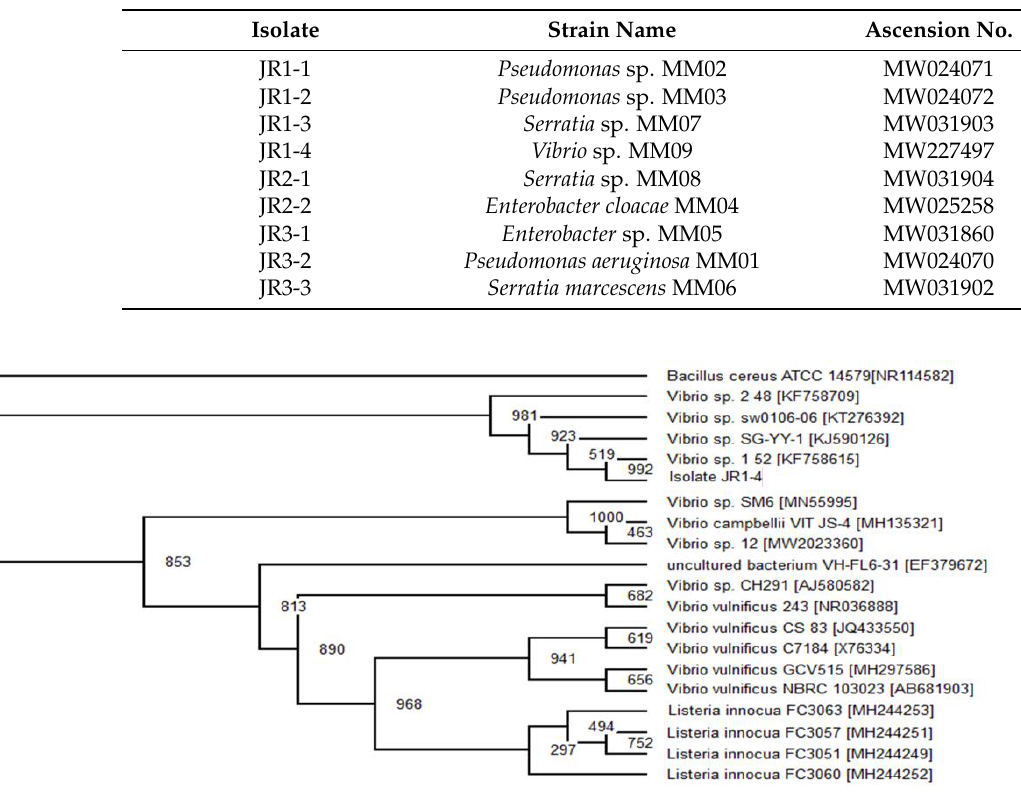
Figure 5. The cladogram was carried our based-on neighbour-joining technique illustrating the phylogenetic relationship of isolate JR1-4 with other interconnected analogous bacterium based on 16S rRNA gene sequence examination. The species names are trailed by the accession numbers of their 16S rRNA. Bacillus cereus was the outgroup.